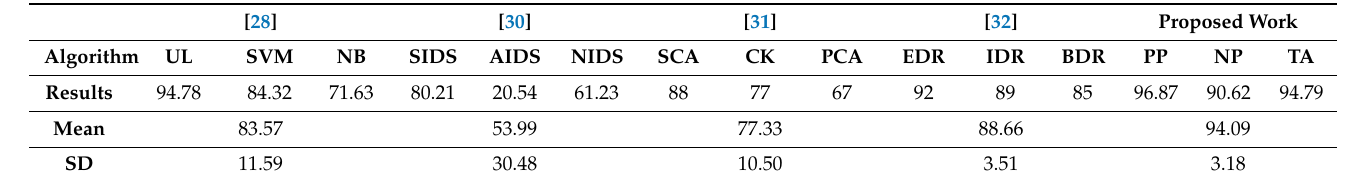
Table 5. Comparative analysis of the accuracy of algorithm